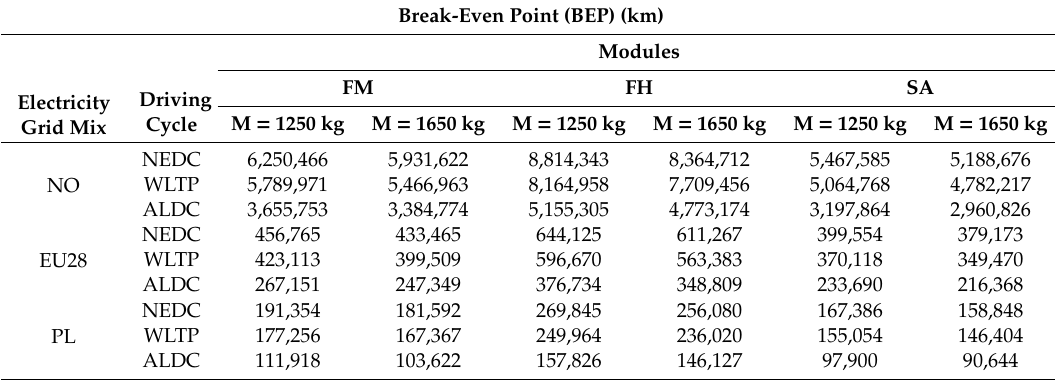
Table A6. BEP for the considered case studies assuming M = 1250 kg and M = 1650